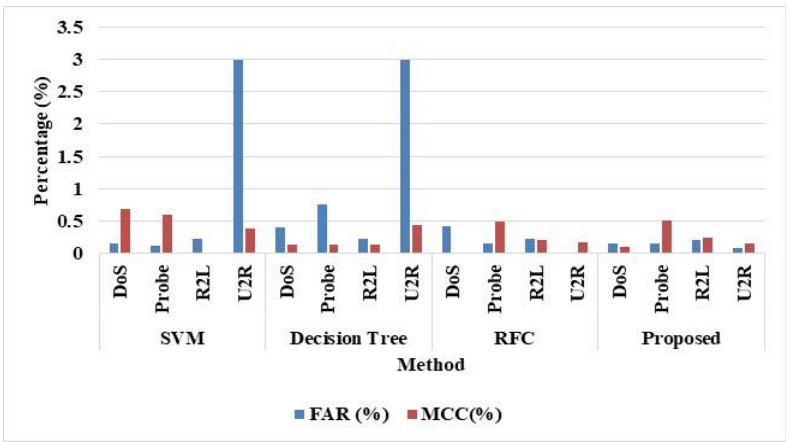
Figure 6. Performance evaluation for the proposed SMO-HPSO for NSL-KDD dataset to multiple attack classes.